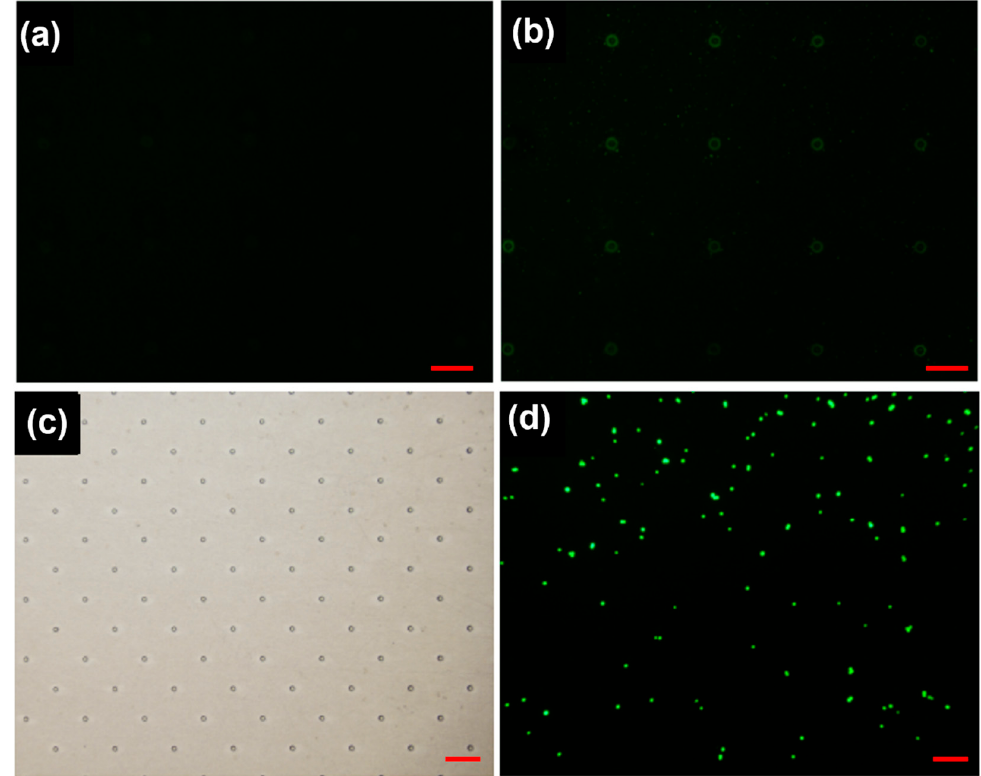
Figure 4. ( a , b ) Verification of a specific antibody modified on the substrates. ( c ) Bright field and ( d ) fluorescence field of the captured cells. The scale bars are 100 µ m in ( a , b ) and 200 µ m in ( c , d ). After the cells were captured on the substrates, SEM was used to characterize the cell morphology. The cells were immobilized by glutaraldehyde for 15 min and then dehydrated sequentially with ethanol at different concentrations, from 30% to 95%, and absolute alcohol. After freeze-drying for 1 h, the cell morphology was characterized using SEM. Figure 5 shows the cancer cells coupled with the PLGA nanofibers, and the microvilli and filopodia of cells attached to the glass surface and PLGA nanofibers, which are labeled by red arrows in Figure 5d. From the side view of captured cells in Figure 5b,d, this 3D substrate can provide a suitable microenvironment for cancer cells.